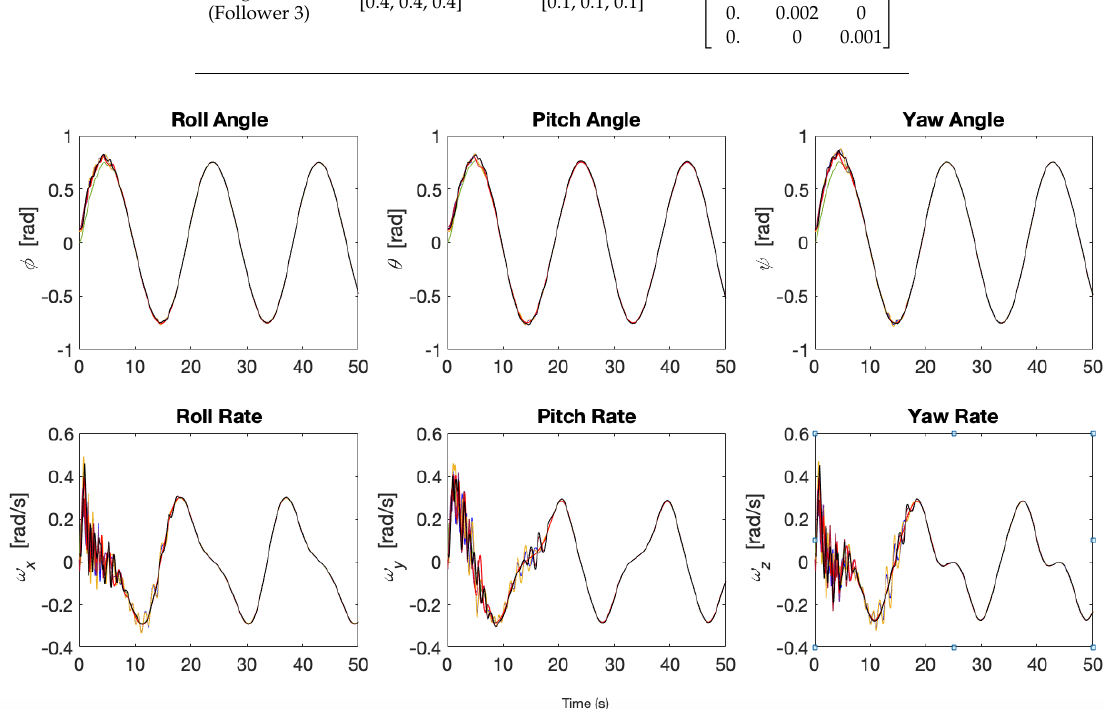
Figure 7. Adaptive spacecraft state synchronization for states ( φ , θ , ψ , ω x , ω y , ω z ) ( µ =